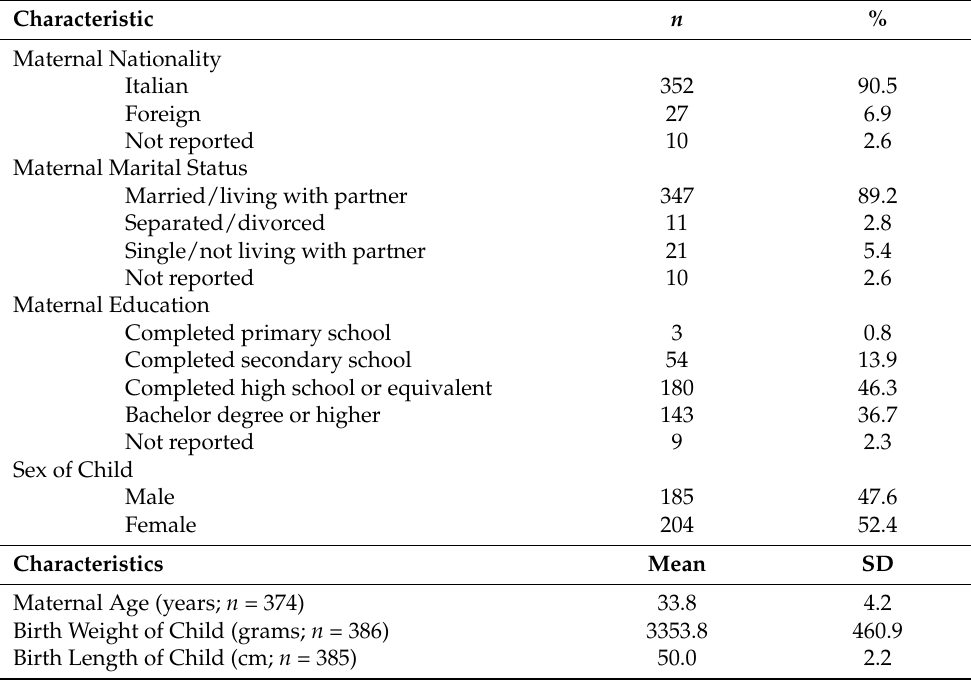
Table 1. General characteristics of mothers at enrollment and children at birth ( n =